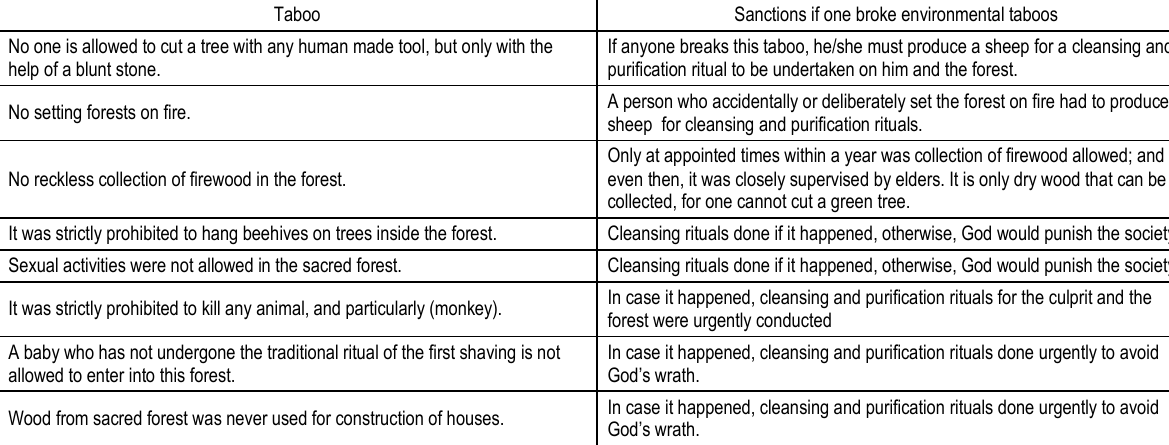
Table 2. Taboos associated with the local forests Taboo Sanctions if one broke environmental